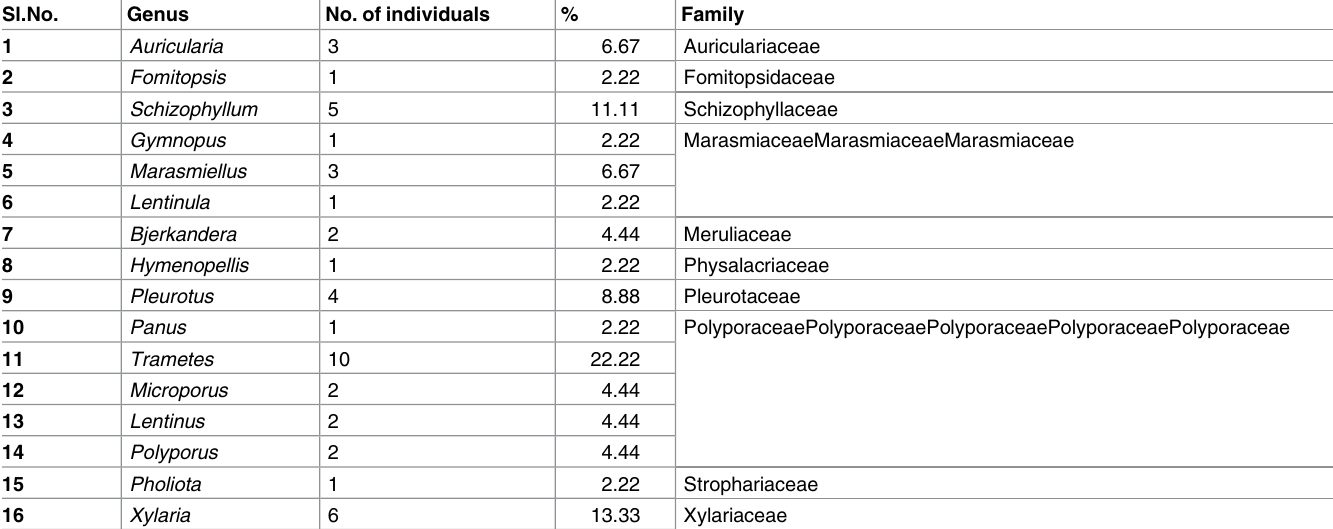
Table 4. ITS rRNA gene analysis classified the isolates into 16 genera and 11 families.